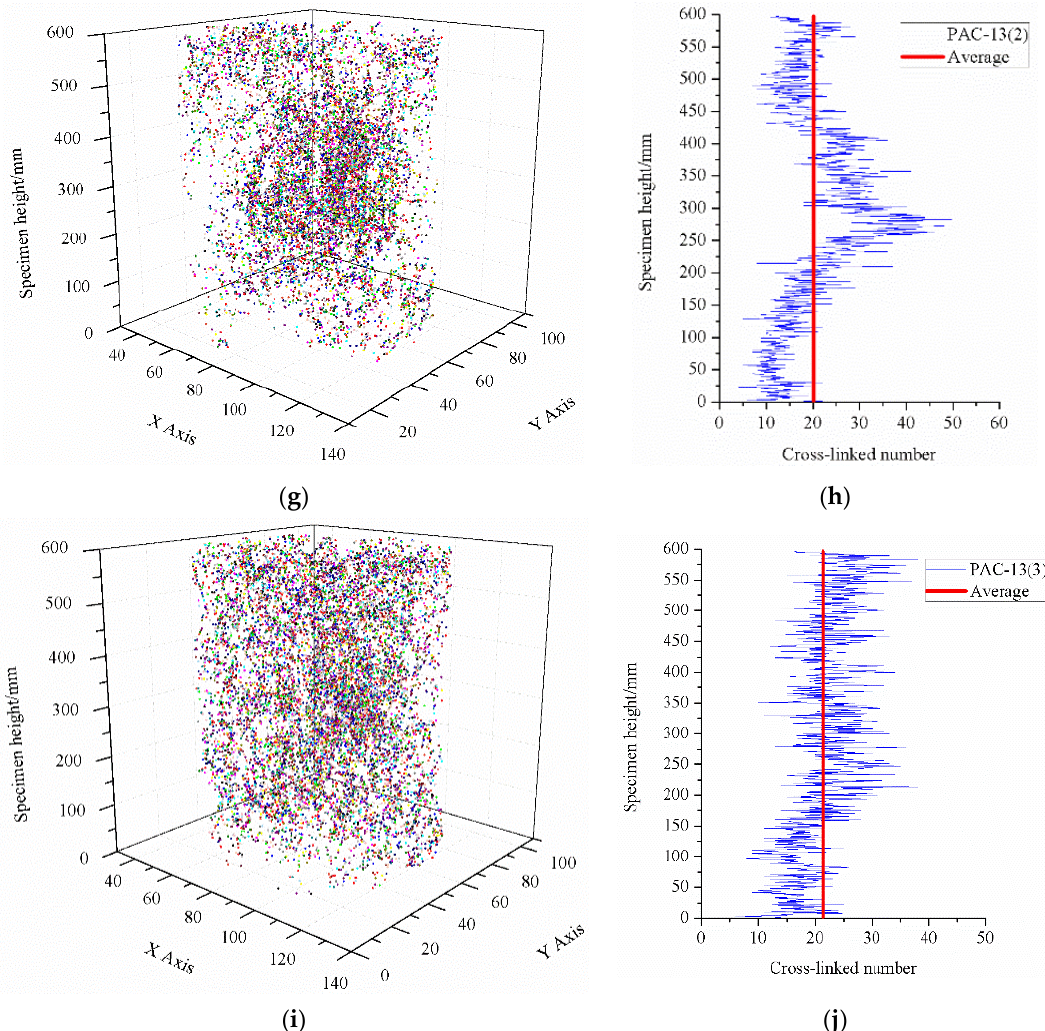
Figure 10. Cross-linked number of interconnected pores along the specimen height direction. ( a ) Cross-linked number spatial distribution of PAC-5; ( b ) Cross-linked number of PAC-5 along the specimen height direction. ( c ) Cross-linked number of the spatial distribution of PAC-10; ( d ) Cross-linked number of PAC-10 along the specimen height direction; ( e ) Cross-linked number of the spatial distribution of PAC-13(1); ( f ) Cross-linked number of PAC-13(1) along the specimen height direction; ( g ) Cross-linked number of the spatial distribution of PAC-13(2); ( h ) Cross-linked number of PAC-13(2) along the specimen height direction ( i ) Cross-linked number spatial distribution of PAC-13(3); ( j ) Cross-linked number of PAC-13(3) along the specimen height direction. Table 5. Cross-linked number properties.